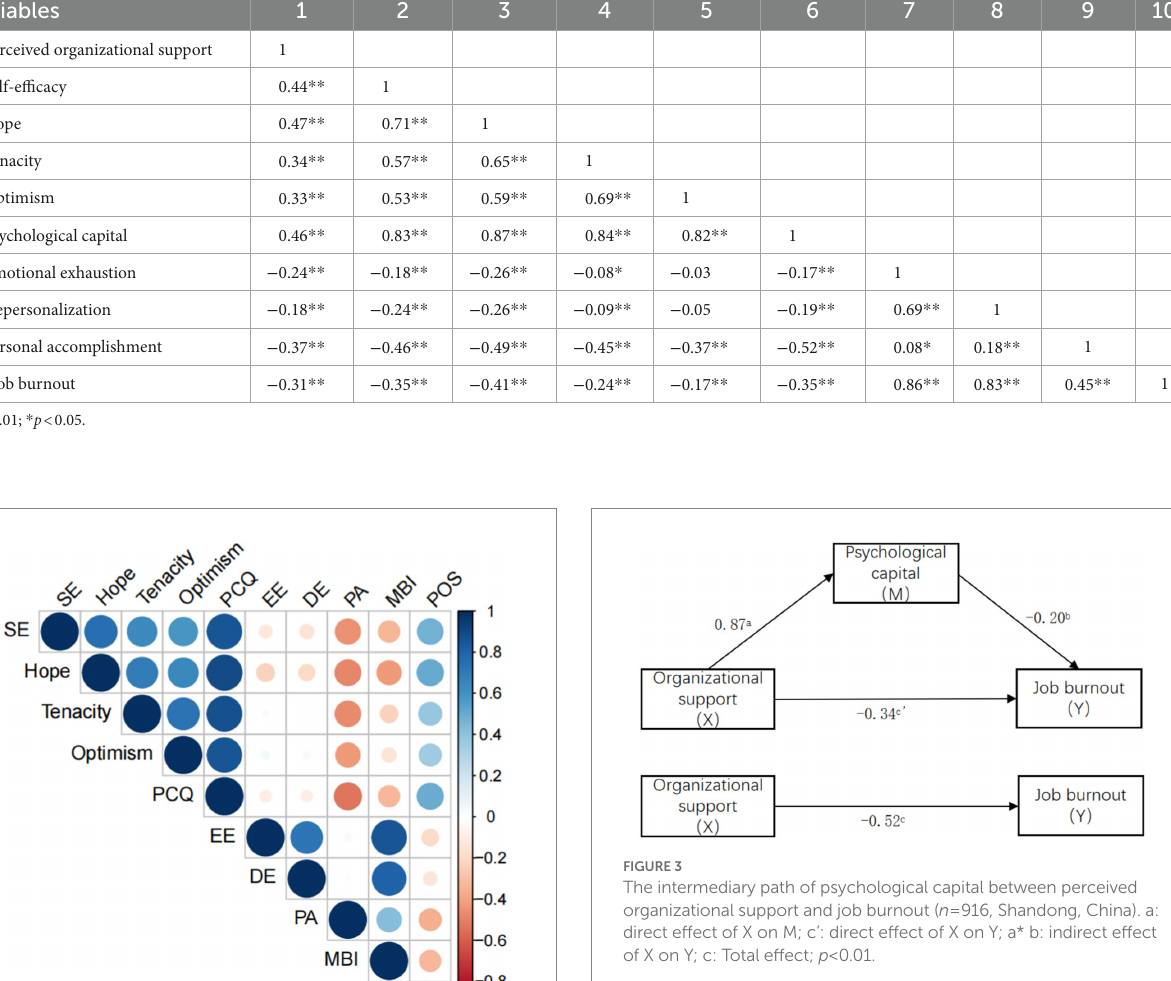
TABLE 2 Correlation between psychiatric nurses’ perceived organizational support, job burnout, and psychological capital ( n = 916, Shandong, China). Variables